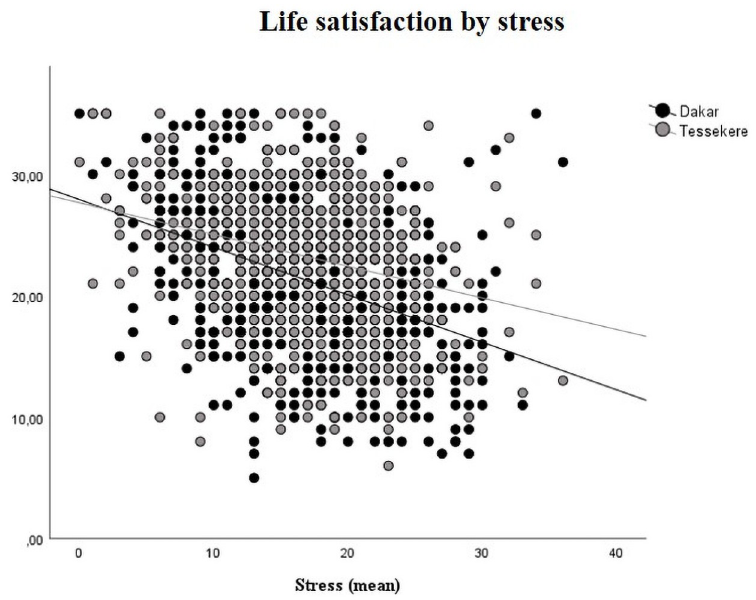
Fig 8. Life satisfaction (mean) by stress and place of life. (N = 1500); � p < 0.05 / �� p < 0.01 / ��� p < 0.001.